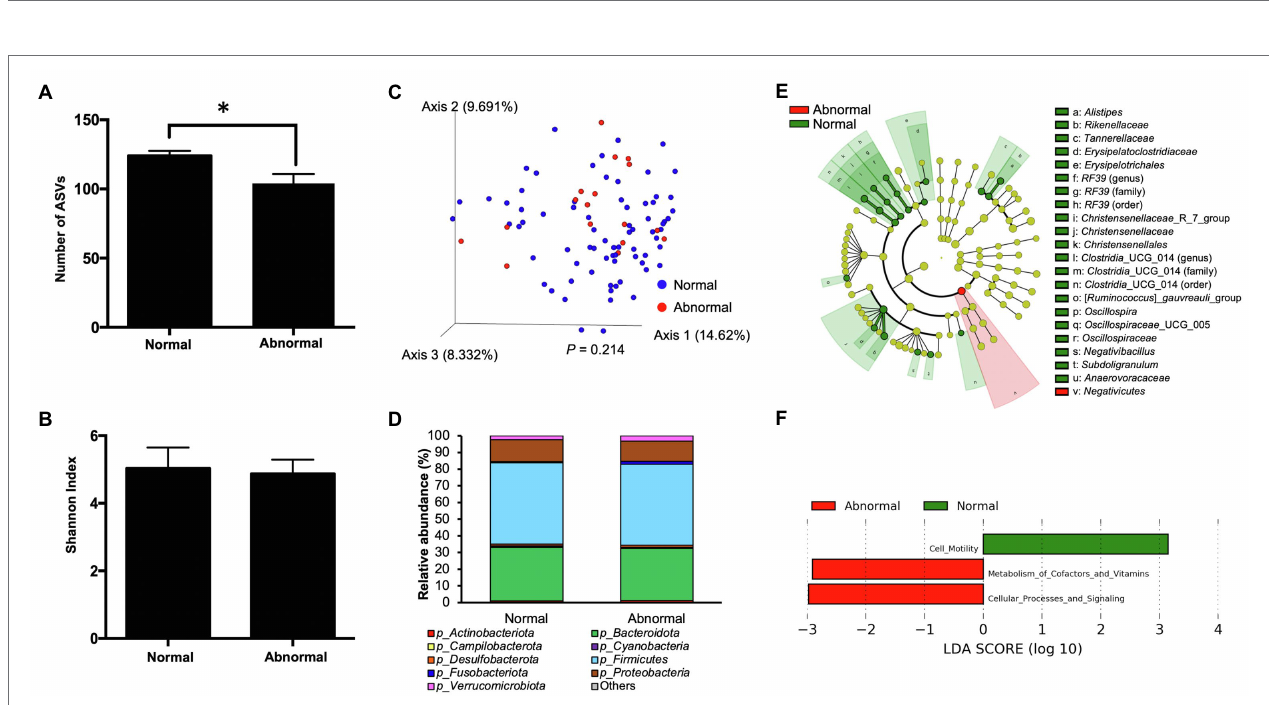
FIGURE 2 | The microbiota characteristics of normal and abnormal feces. (A) The number of amplicon sequence variants (ASVs) of normal and abnormal feces. (B) The Shannon index of normal and abnormal feces. (C) The PCoA plot based on Bray-Curtis distances comparing microbiota composition between normal and abnormal feces. The difference in Bray-Curtis distance was analyzed by the permutational multivariate ANOVA (PERMANOVA). (D) Distribution of abundant bacterial phyla in normal and abnormal feces. (E) The taxonomic cladogram obtained from the linear discriminant analysis effect size (LEfSe) analysis showing the unique bacterial taxa in the normal and abnormal feces. (F) Results of the LEfSe analysis showing microbial function that were significantly different between normal and abnormal